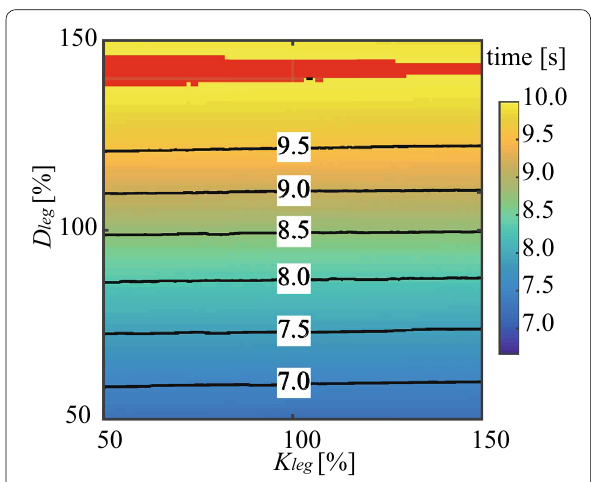
Fig. 8 Time taken for 100-m sprint for the SLIP model with varying K leg and D leg values. Horizontal axis: K leg , vertical axis: D leg of Sprinter 1E90. The 100-m sprint time with the RSP having the corresponding parameters is represented in a color scale ranging from blue to yel- low. The color red indicates that the model falls down before crossing 100